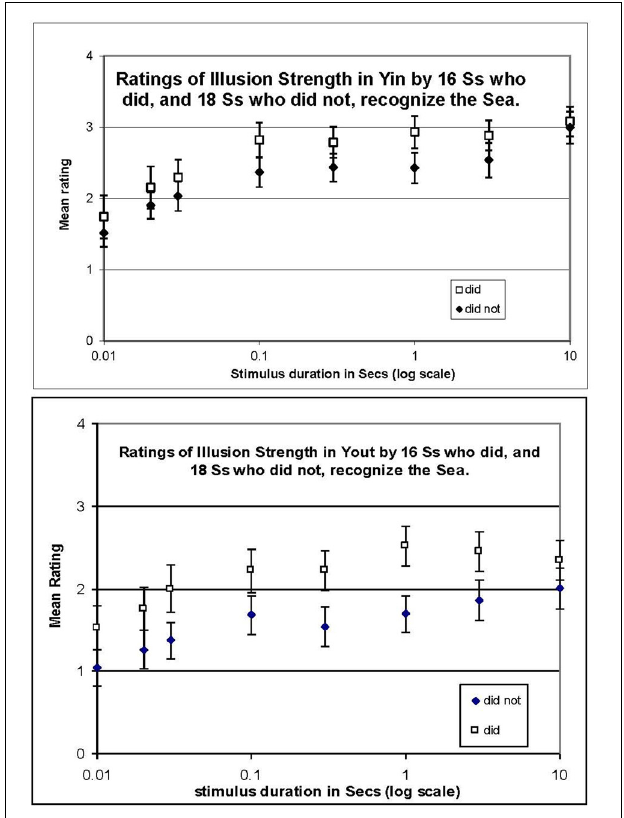
FIGURE 3 | Mean ratings in Experiment 2 with a single fixed anchor stimulus (the cross in Figure 2) rated “4,” and no illusion (gray) rated “0,” for Yin (top panel) and Yout (bottom panel), plotted against stimulus duration in log seconds. Participants who did or did not recognize the Sea are plotted separately. Error bars show ± 1 standard error of each